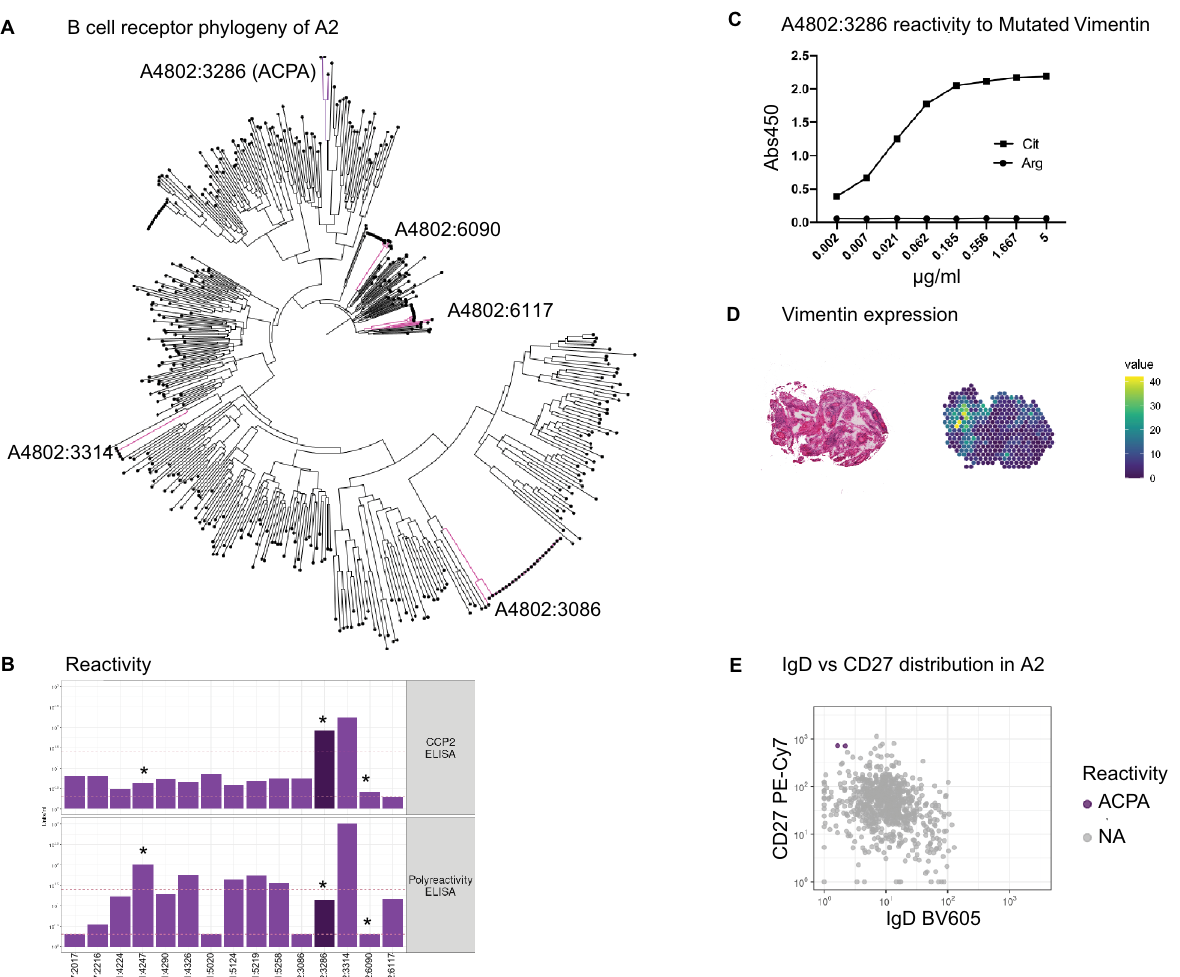
Figure 6. Reactivity landscape of synovial plasma cell derived antibodies. ( A ) Phylogenic tree of the B cell receptor clones of one of the ACPA positive individuals (A2). Clonotypes from figure are highlighted. ( B ) One of the monoclonal antibodies (dark purple) was identified as an anti-citrullinated protein antibody (ACPA) based on being CCP positive (upper panel), but not polyreactive (lower panel). Several antibodies showed polyreactivity. *Indicates insertion of N-linked glycosylation sites by SHM. ( C ) The A4802:3286 ACPA has strong reactivity towards mutated citrullinated vimentin peptide. ( D ) Vimentin is expressed within the corresponding tissue analyzed by spatial transcriptomics. ( E ) The A4802:3286 ACPA derives from two identical IgD− CD27++ plasma